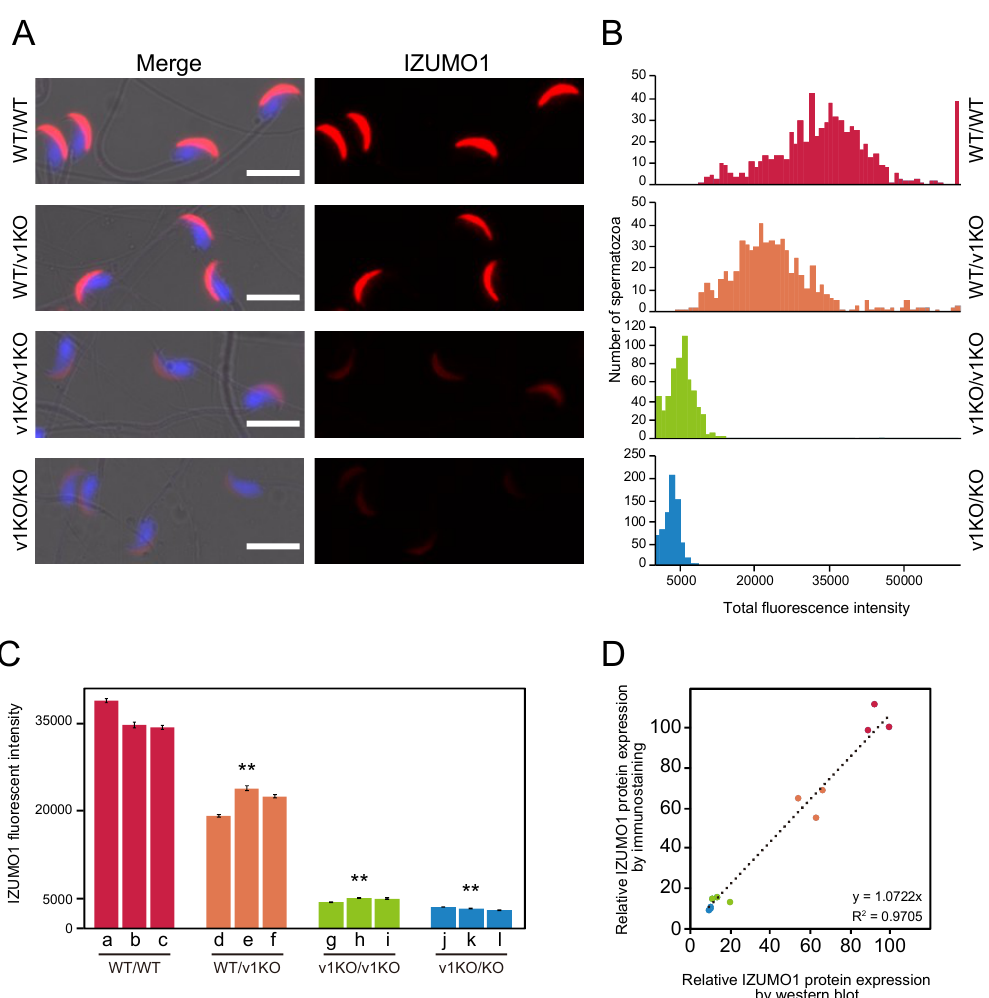
Figure 2. Evaluation of protein levels for IZUMO1 analyzed by immunostaining. ( A ) Immunostaining of spermatozoa with 0.5 μg/mL of monoclonal anti-IZUMO1 antibody (Mab34)-conjugated to Alexa Fluor 546 (red). Sperm nuclei are stained with Hoechst 33342 (blue). Scale bar is 10 μm. ( B ) Histograms of normalized fluorescence intensity obtained from spermatozoa shown by immunostaining. ( C ) Average of fluorescence intensity from individual spermatozoa. Each bar represents an individual spermatozoa (each alphabetical letter corresponds to Figure 1A.) from four mouse lines. Significant differences: ** p <0.01 (Student’s t -test) compared to WT/WT. ( D ) Comparison of relative IZUMO1 protein values obtained via two methods. Each specimen derivation between the two methods is identical. The color scheme is the same as that in Figure 1B.